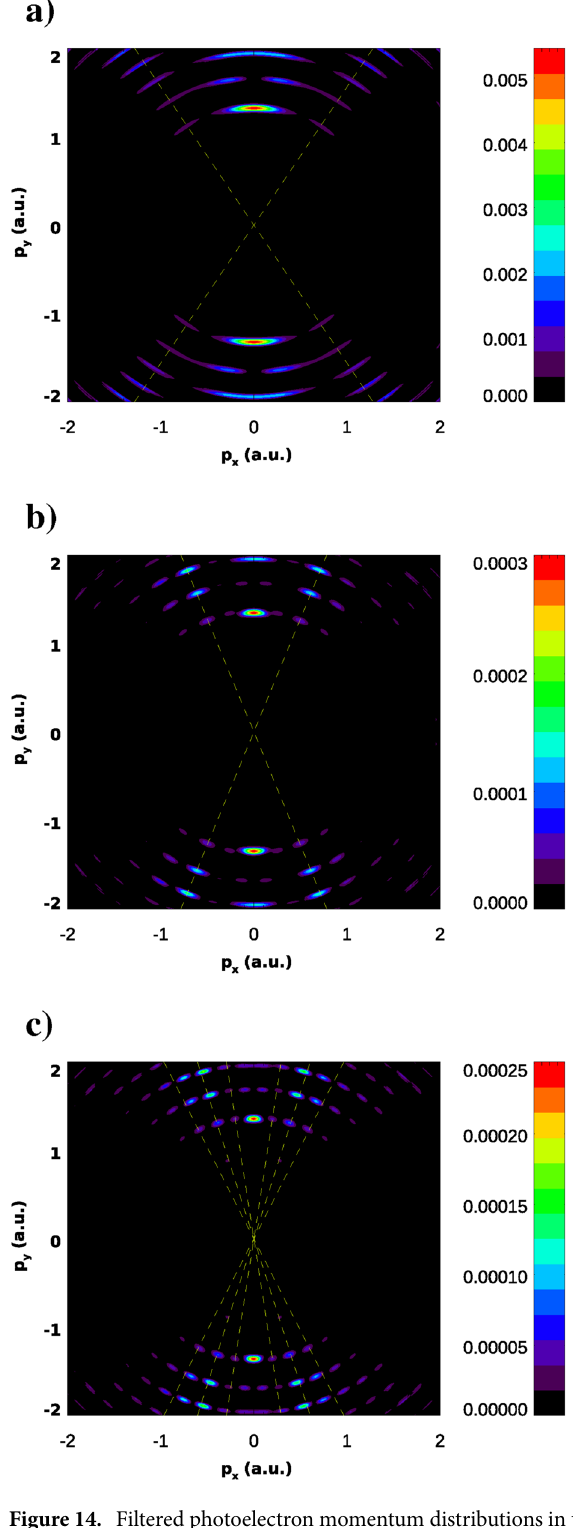
1.84 a.u. ( a ), E 0 3.07 = = 0.05 a.u., (cid:31) 1 a.u. Lines show directions to low = =